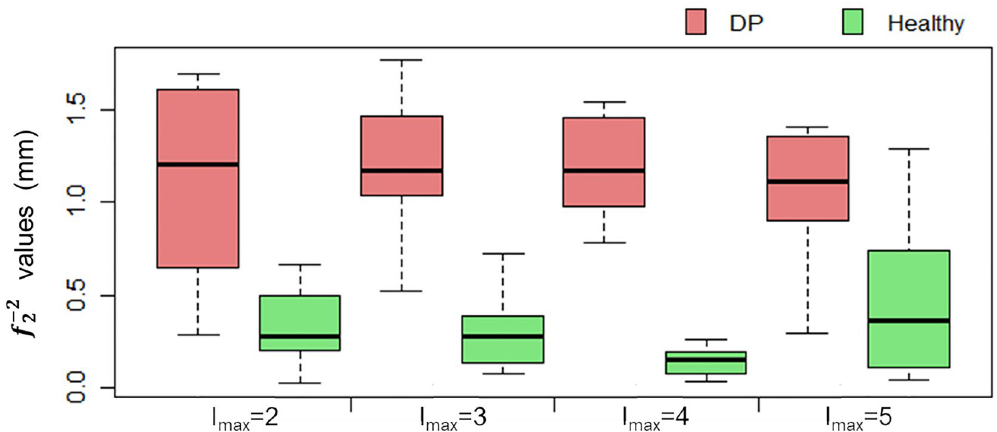
− 2 2 calculated with different lmax values for the two groups of